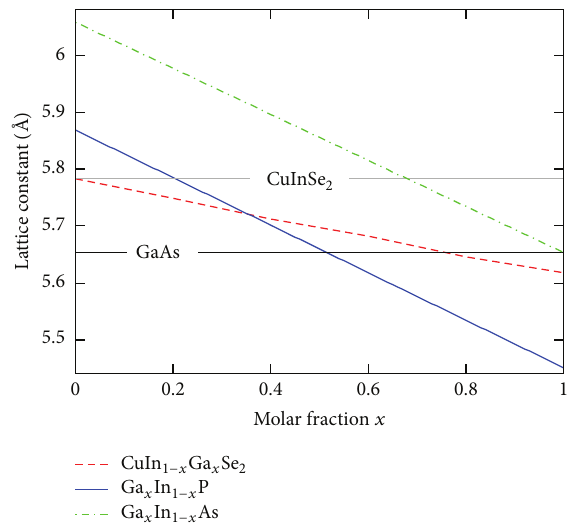
Figure 3: Lattice constant as a function of molar fraction for Ga Se 2 , Ga In 1− P, and Ga CuIn 1− x x x x